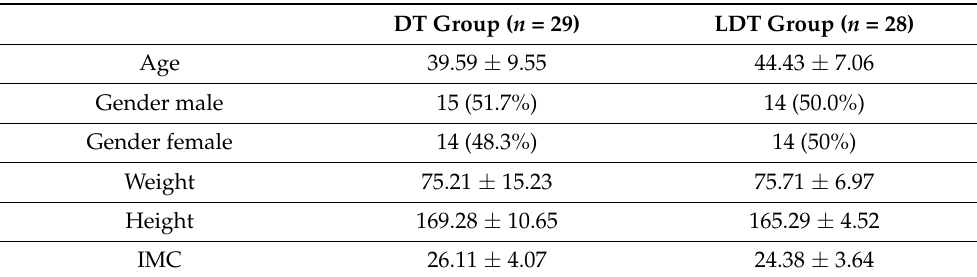
Table 1. Demographic data of groups.